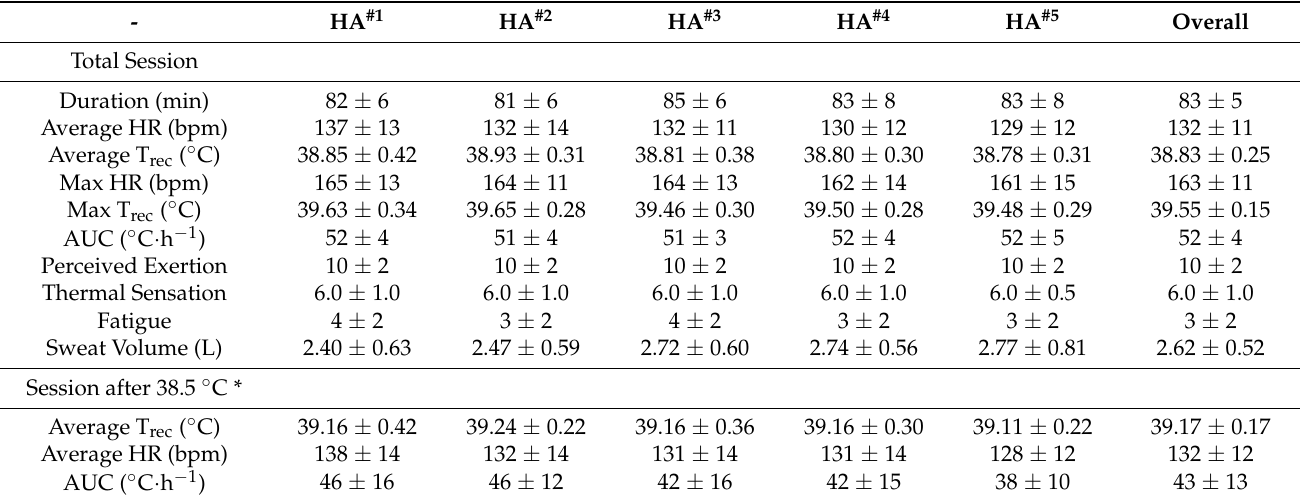
Table 2. Physiological variables collected throughout the 5-day heat acclimation protocol. Data are reported as mean ± stan- dard deviation.